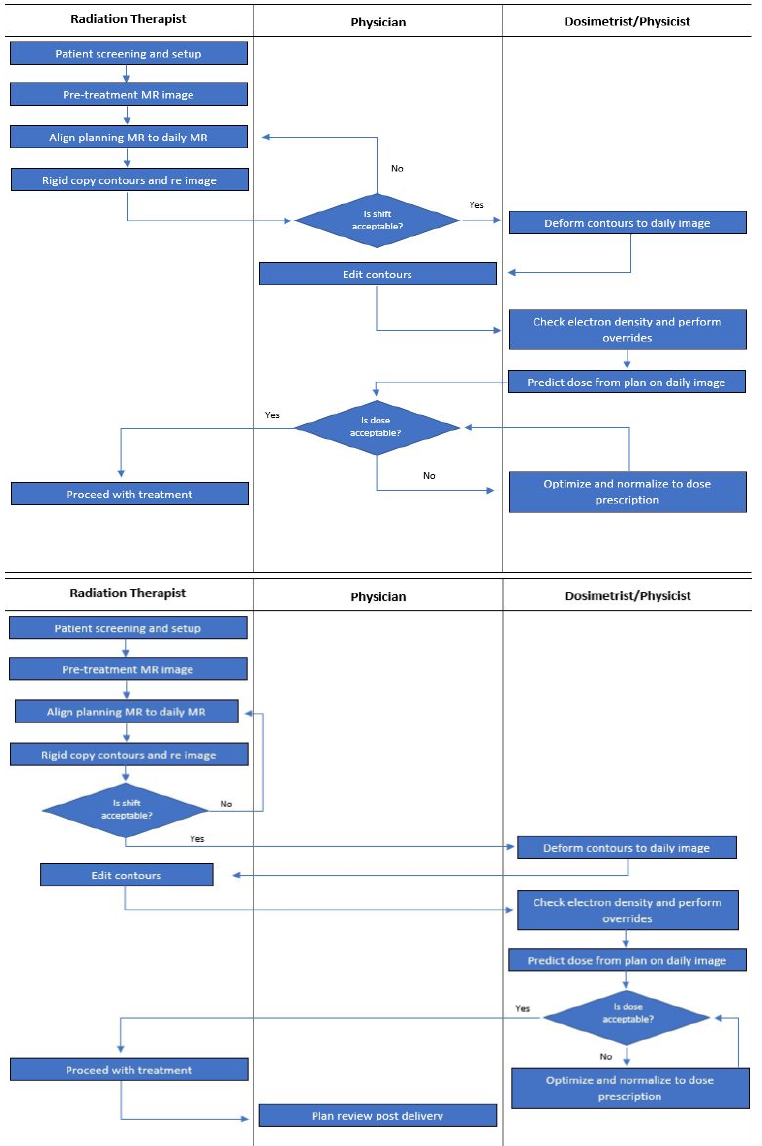
Figure 2. Swim lane depiction of current (top) and proposed (bottom) adaptive radio therapy workflows on an MR-LINAC.